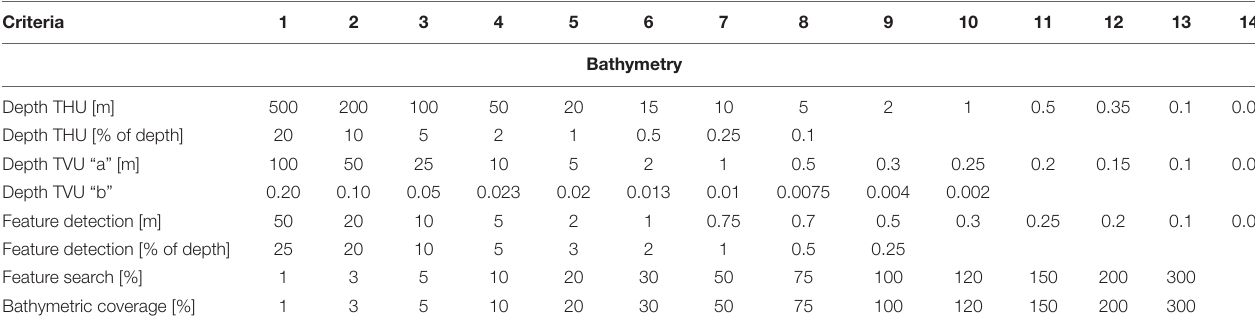
TABLE 3 | IHO S-44 new matrix of specifications for hydrographic